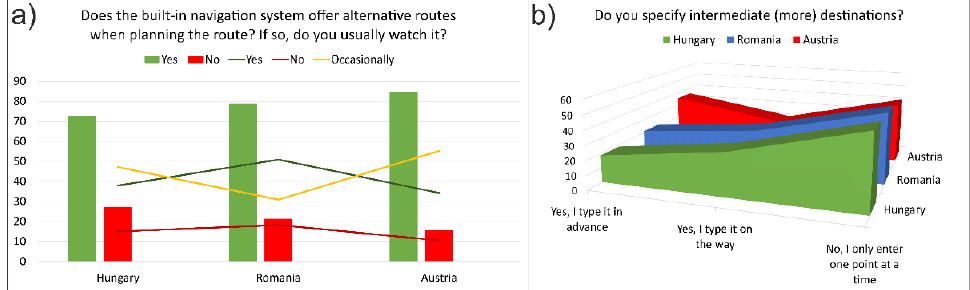
Figure 7. Answers about ( a ) alternative routes and ( b ) intermediate destinations.